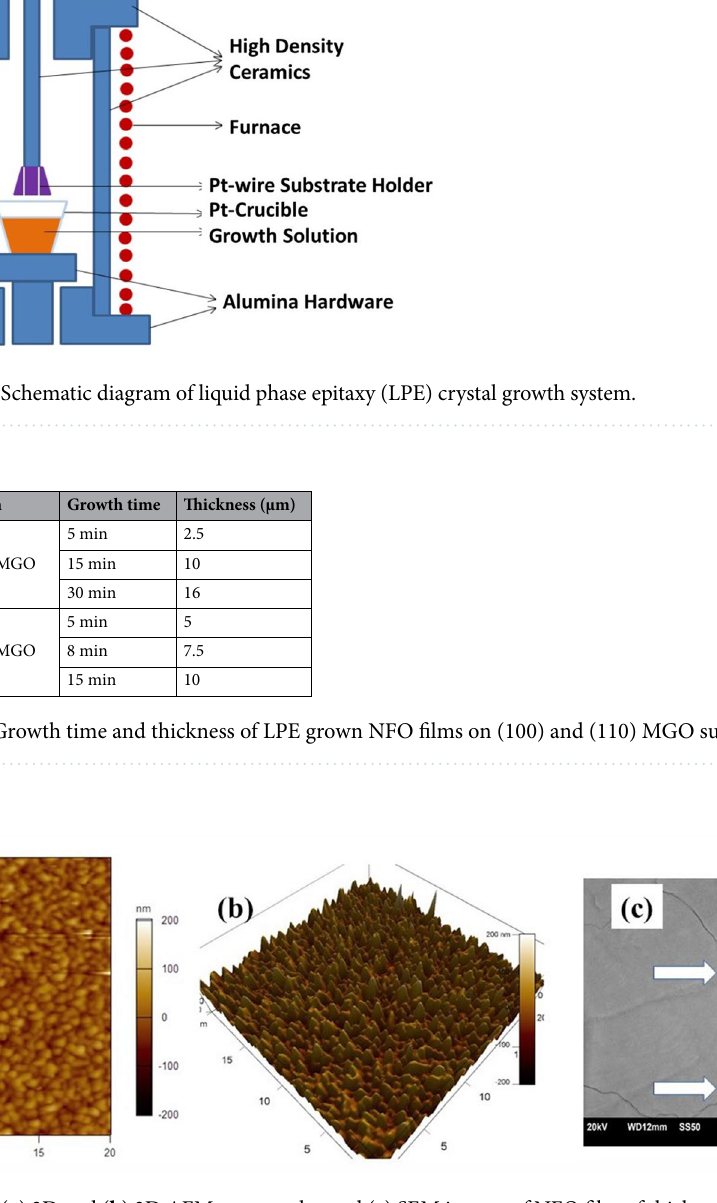
Figure 2. ( a ) 2D and ( b ) 3D AFM topography, and ( c ) SEM images of NFO film of thickness of 2.5 μm on (100) MGO substrate. The arrows indicate a few fine nanometer wide cracks on the film